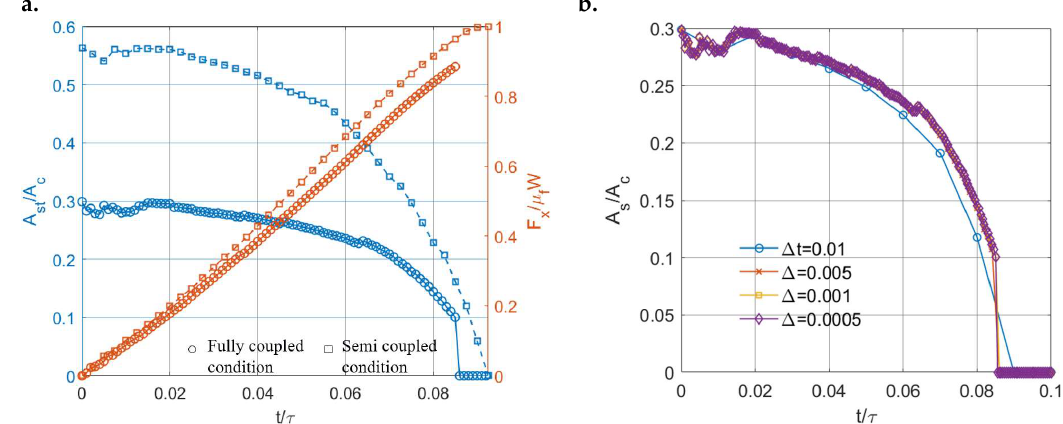
Figure 24. ( a ) Comparison of partial slip solutions under fully coupled (circle) and semi-coupled (square) conditions and ( b ) Comparison of partial slip solutions using different time intervals ( Δ ) under fully coupled conditions.